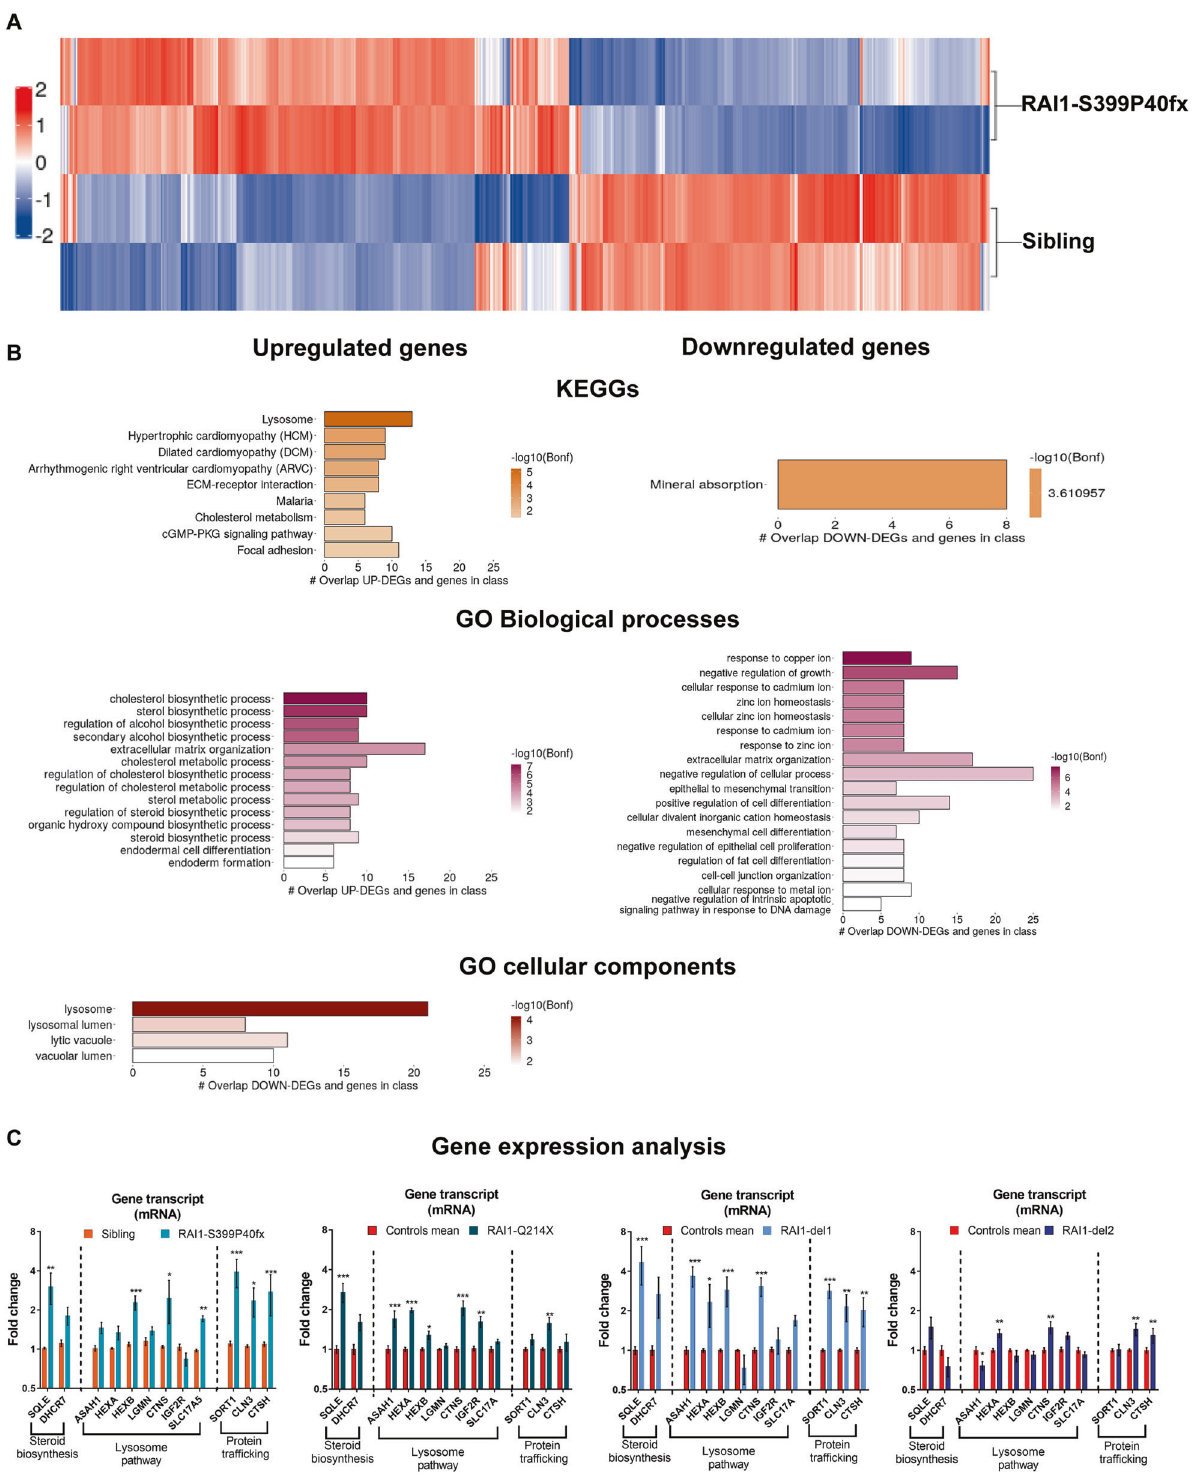
Fig. 2 RAI1 haploinsuf fi ciency alters the expression of genes involved in lipid metabolism, lysosome function and protein/lipid traf fi cking. A Heatmap of the 25% most variable coding genes ( n = 6183) identi fi ed from the whole-genome microarray analysis of RAI1- S399P40fx and sibling cells. The Z scores of gene expression are depicted as a gradient from blue (low expression) to red (high expression) ( n = 2 biological replicates). B Kyoto Encyclopedia of Genes and Genomes (KEGG) and Gene Ontology (GO) analysis of DEGs in RAI1-S399P40fx cells relative to sibling cells. C Quantitative real-time PCR of selected genes in four SMS cell lines and four control cell lines ( n = 5 biological replicates). Control = average CTR1/2/3. Graphs: mean ± SEM, one-way ANOVA + Newman – Keuls post hoc test, * p < 0.05, ** p < 0.01, *** p < 0.001.